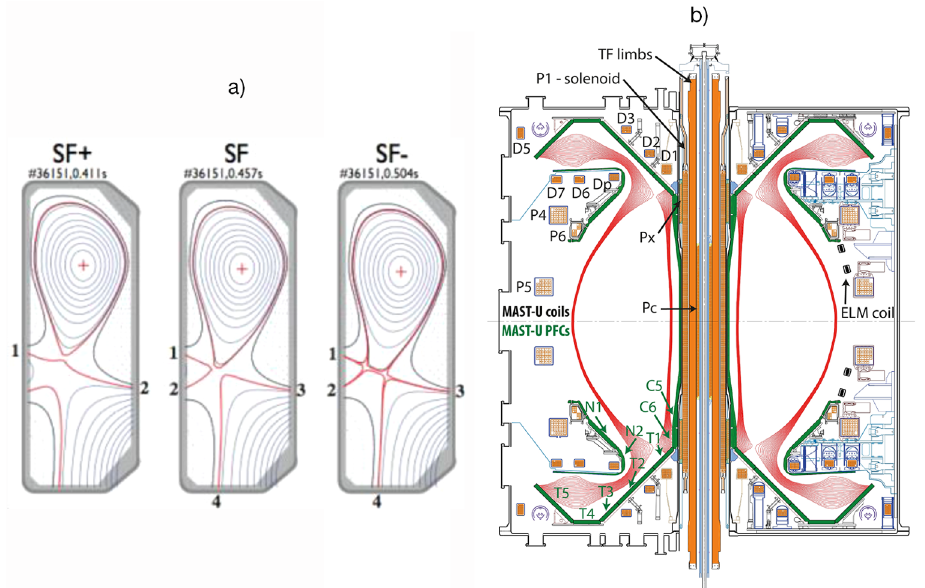
Fig. 6. – (a) Snowflake divertor configuration tested on the TCV tokamak (from ref. [16]). (b) Super-X configuration to be tested on the MAST-U tokamak (from ref.